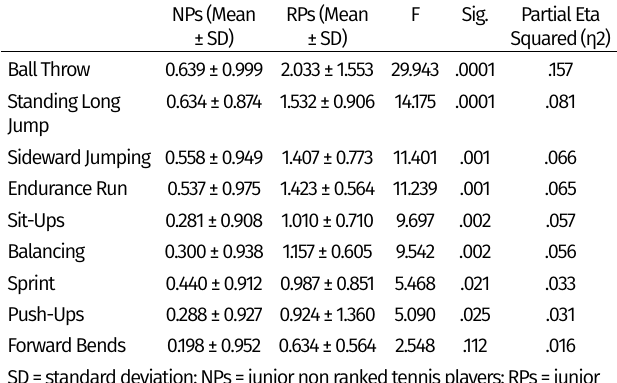
Table 2. ‒ Results of the MANCOVA for the different former U9 test disciplines